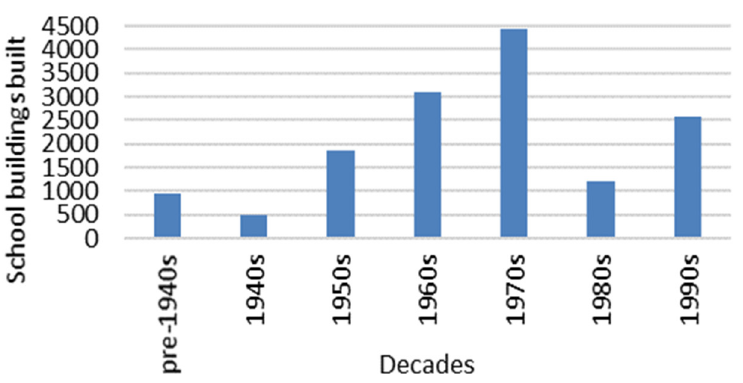
Figure 1. Number of school buildings built from pre-1940s to 1990s in New Zealand (source: the data was provided by the New Zealand Ministry of Education).